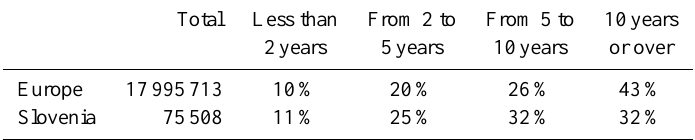
Table 6. Statistics on lorries age in year 2011 for Europe and Slovenia. Total Less than From 2